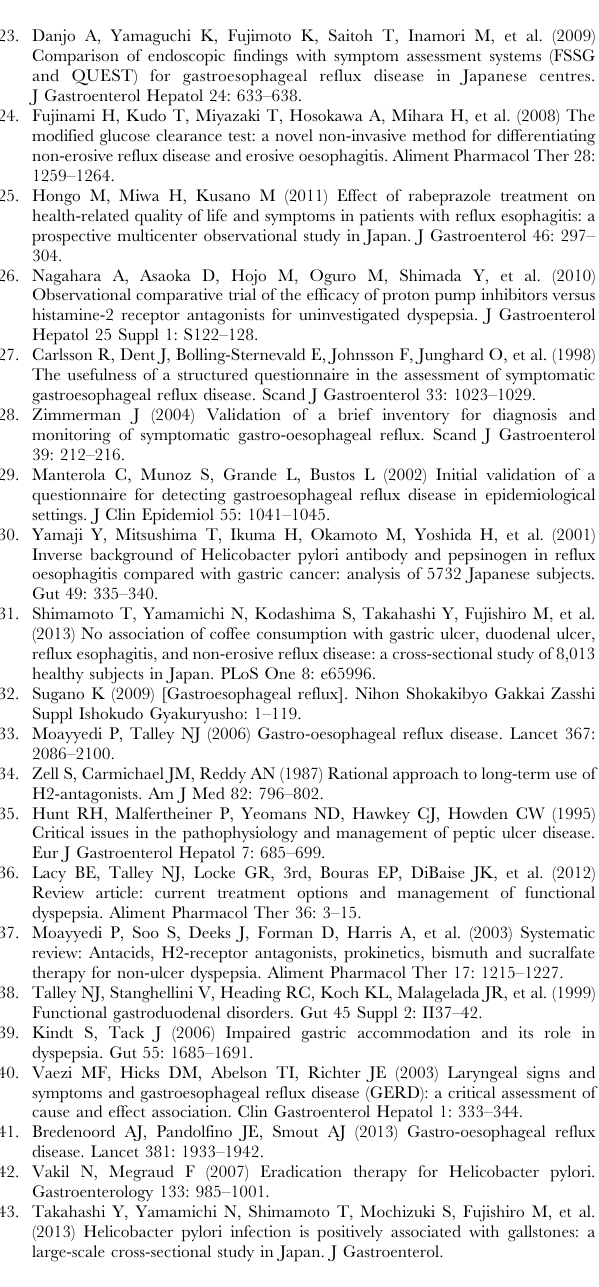
Table S2 The effect sizes and power for the 13 variables in the three multivariate analyses concerning the 18,097 digestive drug-free users, 364 PPI users, and 528 H 2 RA